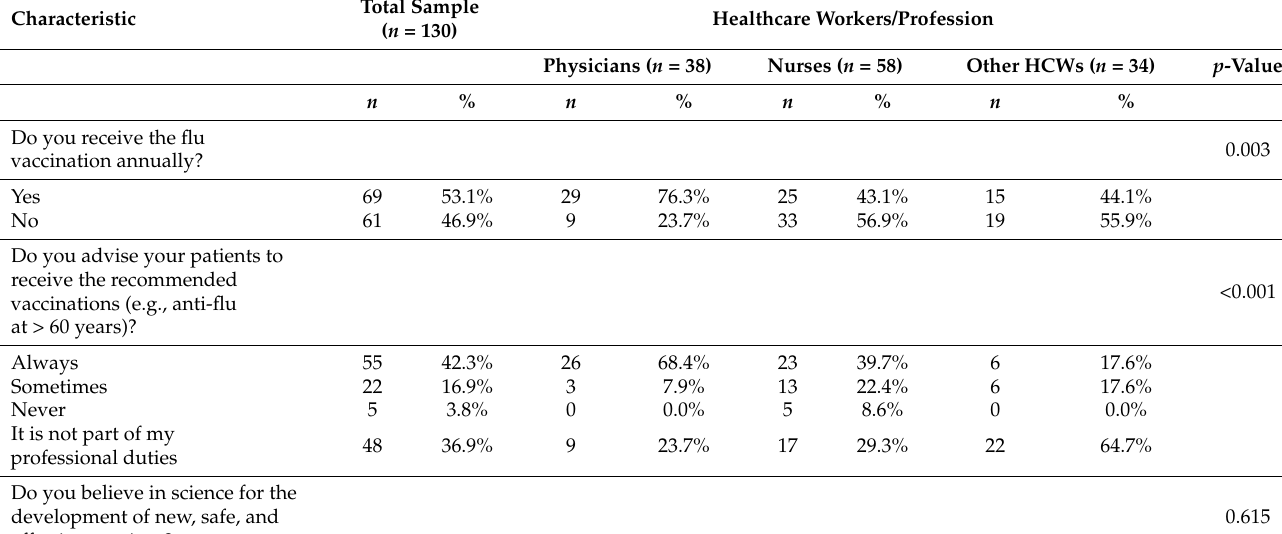
Table 4. General attitudes of healthcare workers towards vaccinations (both recommended and anti-SARS-CoV-2), personal opinions about mandatory vaccination, and main reasons for joining or not joining the vaccination